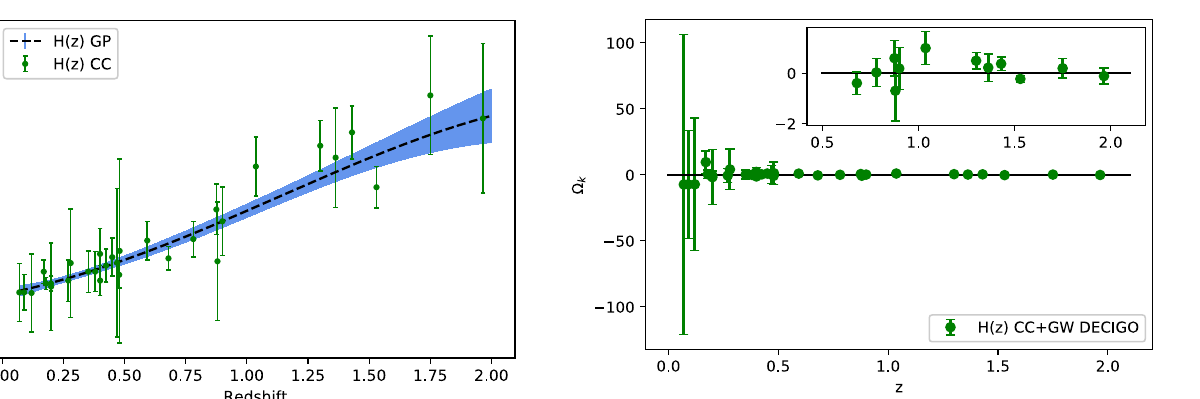
Fig. 5 The latest measurements of 31 Hubble parameters from the galaxy differential age method and the H ( z ) reconstruction function with GP. Green dots denote CC measurements with corresponding 1- σ uncertainties. Black line and blue region represent the reconstructed H ( z ) function and its 1- σ uncertainty band